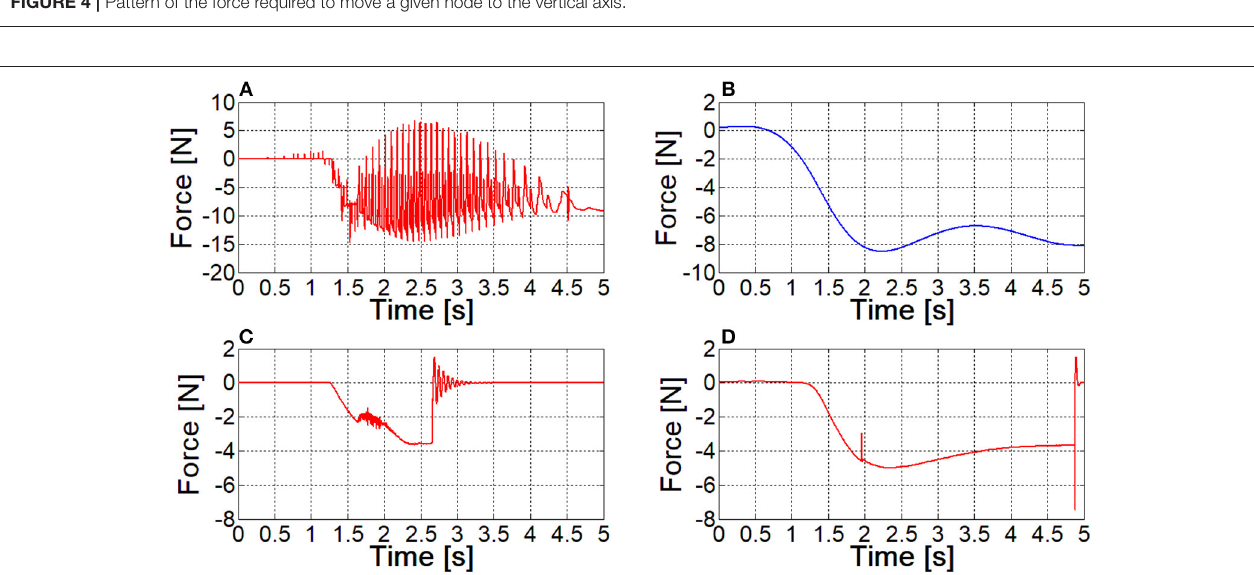
Frontiers in Bioengineering and Biotechnology | www.frontiersin.org